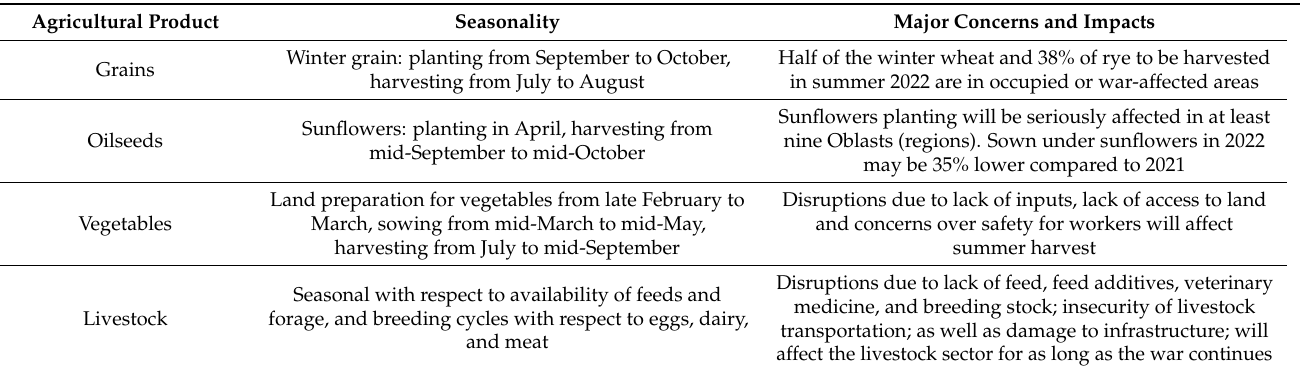
Table 2. Major agricultural products in Ukraine affected by the war. Based on data from